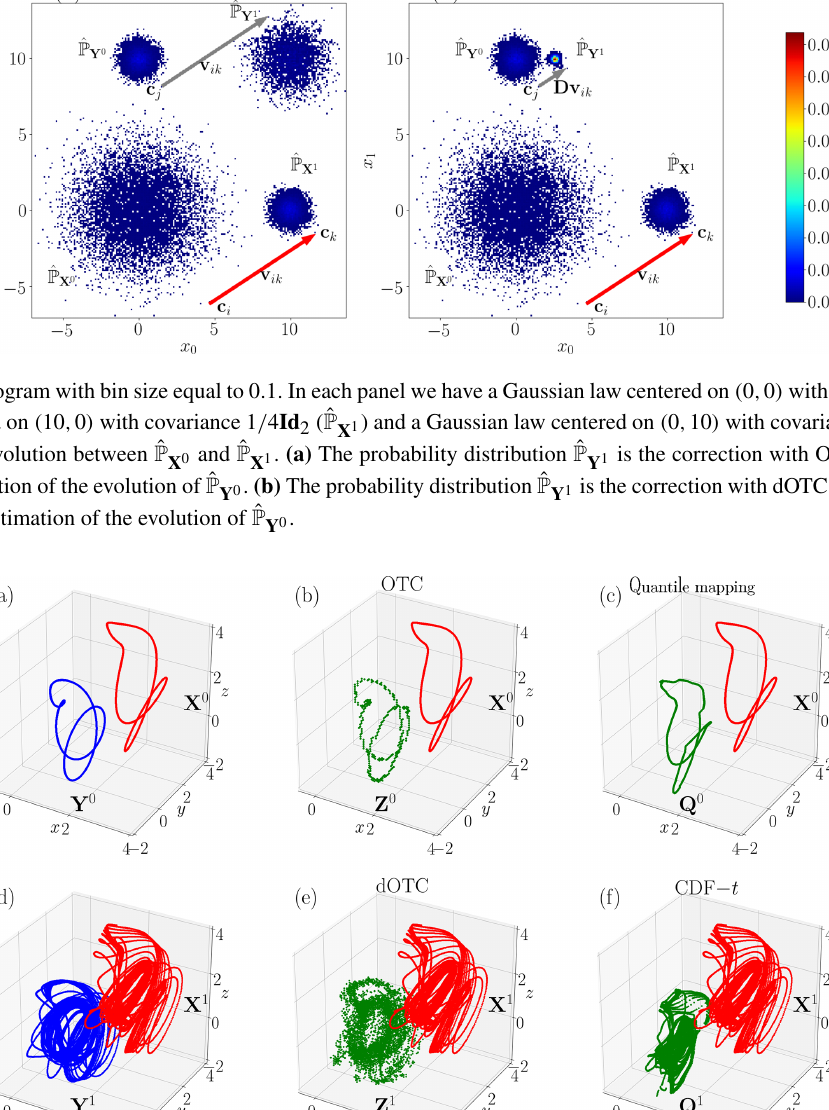
Figure 4. Random variables generated by the Lorenz (1984) model, OTC, dOTC, quantile mapping and CDF- t . (a) Biased random variable X 0 (red) and references Y 0 (blue) for time period 0. (b) Biased random variable X 0 (red) and correction Z 0 with OTC (green). (c) Biased random variable X 0 (red) and correction Q 0 with quantile mapping (green). (d) Biased random variable X 1 (red) and references Y 1 (blue) for time period 1. (e) Biased random variable X 1 (red) and correction Z 1 with dOTC (green). (f) Biased random variable X 1 (red) and correction Q 1 with CDF- t